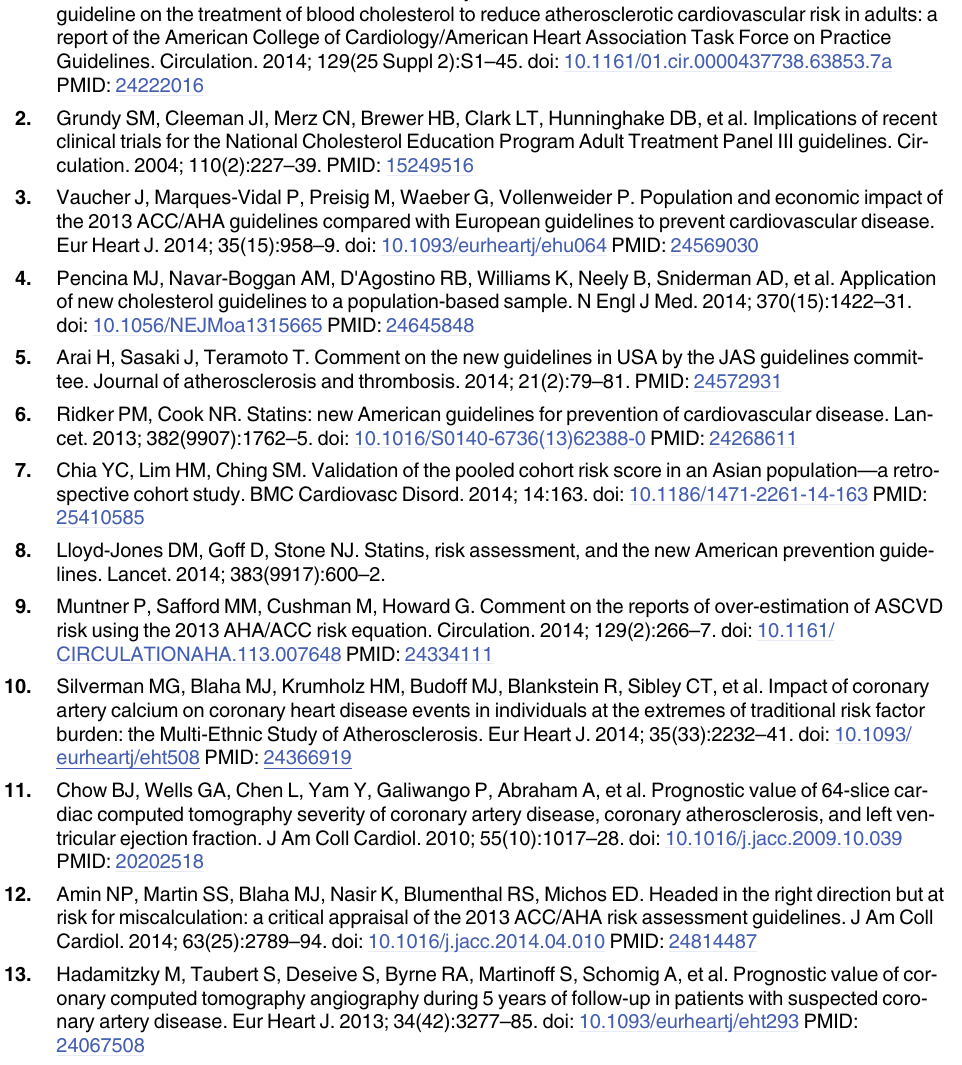
S1 Table. Clinical characteristics of subjects for whom statins would be assigned/would not be assigned according to 2004 ATP III and 2013 ACC/AHA